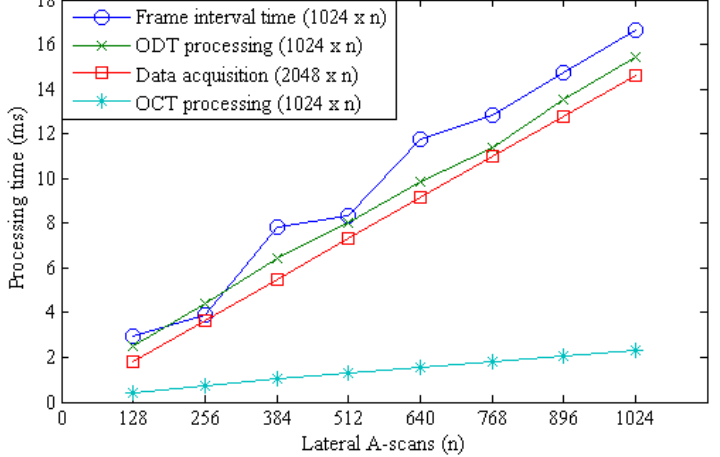
Figure 5. Comparison in ODT processing time between lateral A-scans numbers. Averaging window size: 12 + 20 ( M + N ).